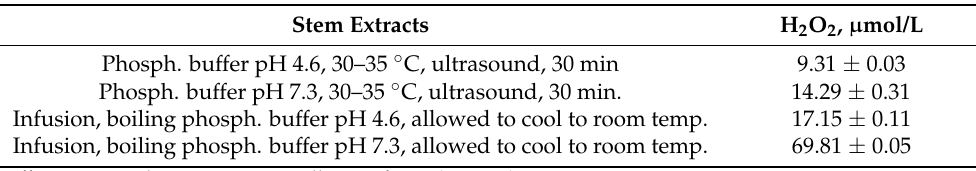
Table 4. The amount of hydrogen peroxide in R. idaeus stem extracts and infusions produced in 30 min.